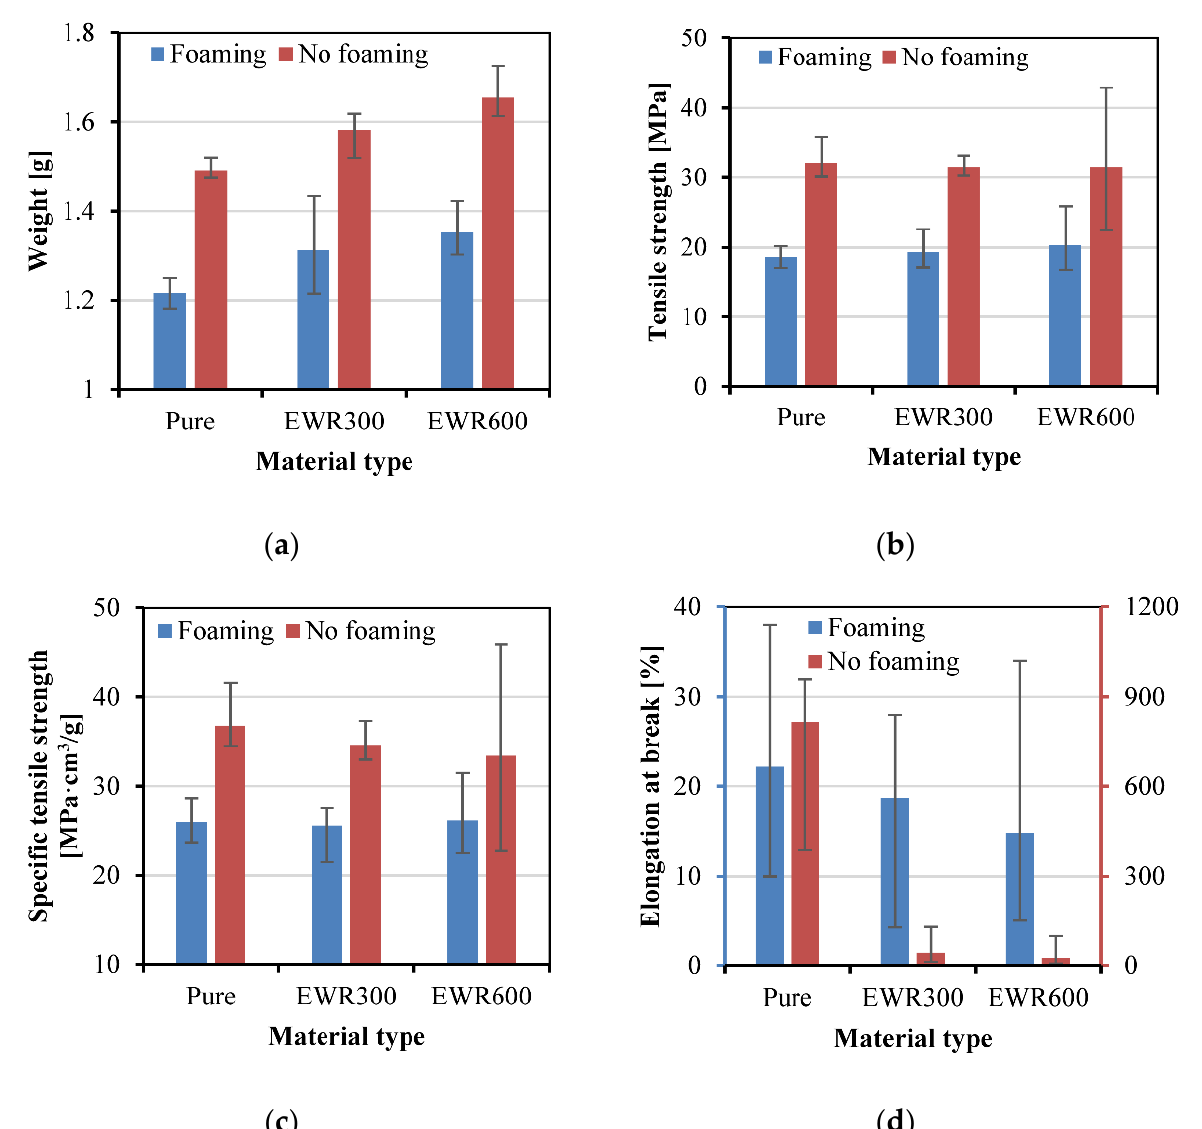
Figure 14. Weight ( a ), tensile strength ( b ), specific tensile strength ( c ), and elongation at break ( d ) of the samples without and with GFF reinforcement.